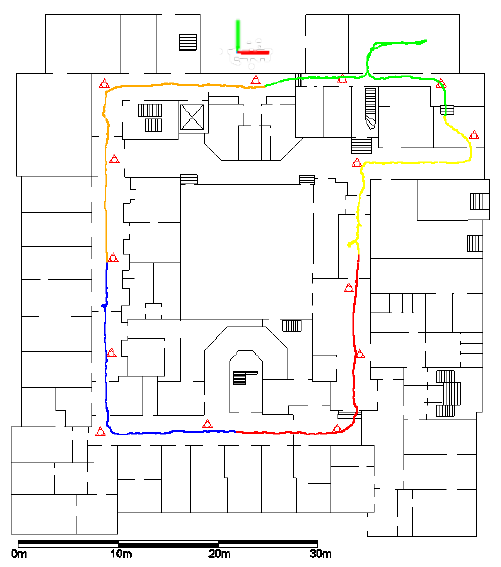
Figure 6. Distribution of static stations (red triangles) and segments of point clouds (on color per segment) of the MMS created along the trajectory.